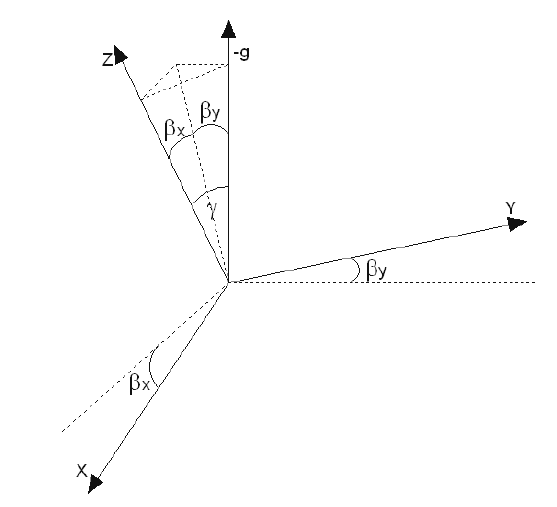
Figure 6. The relationship between the angles β the sensor tilt and is measured between the sensor’s Z-axis and the − g